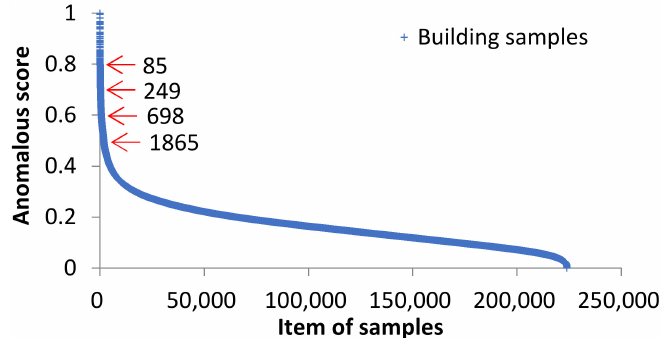
Figure 4. The average anomalous score of each EPC records calculated by IF